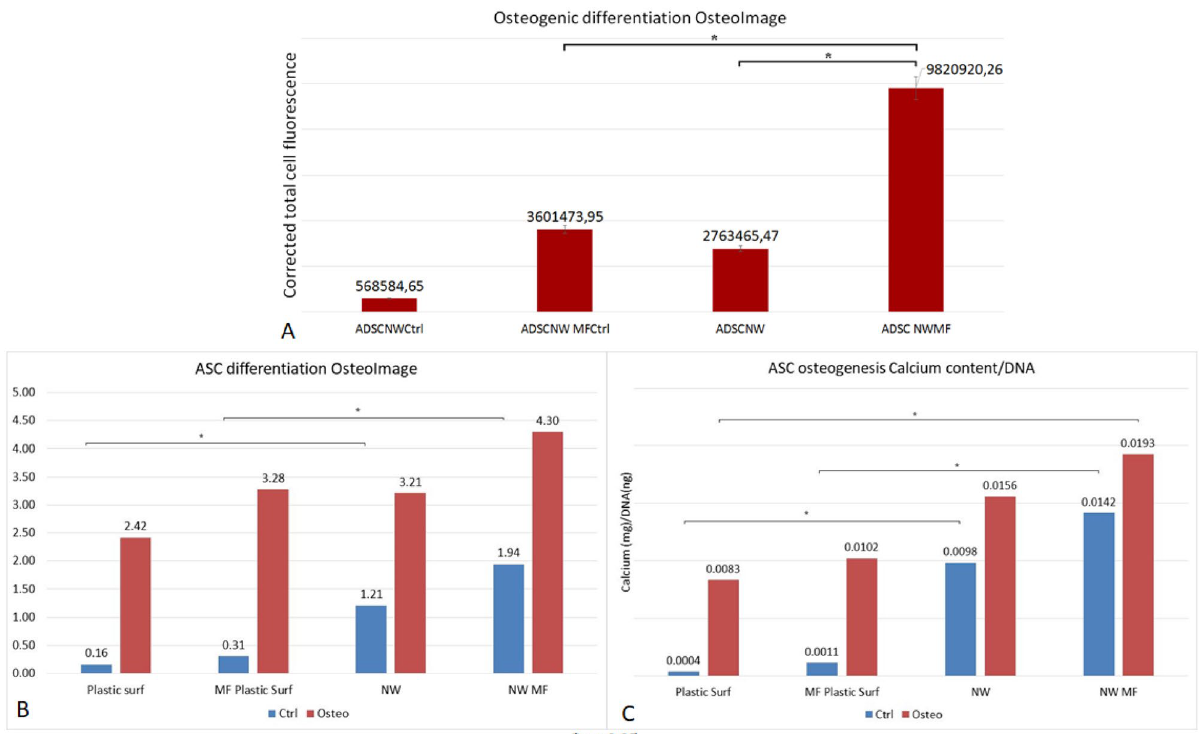
Figure 7. Quantitation of matrix mineralization expressing ASCs osteogenic differentiation: ( A ) semiquantitative assessment of media OsteoImage ® fluorescenxe using Image J software; ( B ) Comparative quantitative assessment of ASCs osteogenesis on regular adherent plastic surfaces and magnetic nanowire substrates (NW) exposed or non-exposed to 0,5 mT alternating magnetic field (MF) relative to DNA content; ( C ) assessment of Calcium content of the mineralized matrix deposited by ASCs on regular adherent plastic surfaces compared to NW surfaces exposed and non-exposed to 1–2 µm scaled but parallel pillars, fact that needs further confirmation. Previous study revealed that human MSC cultured on vertically aligned silicon nanowire (Si NW) displayed good viability and comparable proliferation quantitative comparative evaluation of the number of cells attached to NW substrate in the case of NW placed in ULA plates, and regular adherent plastic culture dish. However, qualitative information resulting from observing the amount of cell nuclei on NW placed in adherent and ULA culture dishes lead to the conclusion that very few cells can be found in the first situation. We decided to perform differentiation experiments with cells on NW in ULA plates only. Since the purpose of the study was to investigate if ASCs differentiation on NW is influenced by MF exposure, a comparative investigation of the conversion efficiency between NW substrates and regular adherent plastic dishes was performed as well. Considering placing NW-filled alumina membrane within alternating MF for delivery of magneto-mechanical stimulation, we performed a theoretical modelling 30 for approximating the magnetic field distribution, especially around the ends of the nanowires. The dynamic of the NW in the alternating MF produced by the coils depends on a series of factors. First, because NW are outside the membrane at their top (Fig. 1A), the free endings follow the dynamic processes imposed by the MF and bend depending on the intensity and frequency of the applied field. This leads to a complex fluctuation of the field in the entire cells area, while allowing the fields generated around the tips to pulsate inside the cell with the frequency of changing the polarity of the coils. The bending amplitude and the associated radius of curvature are related to a series of forces such as magnetic, inertial, elastic,